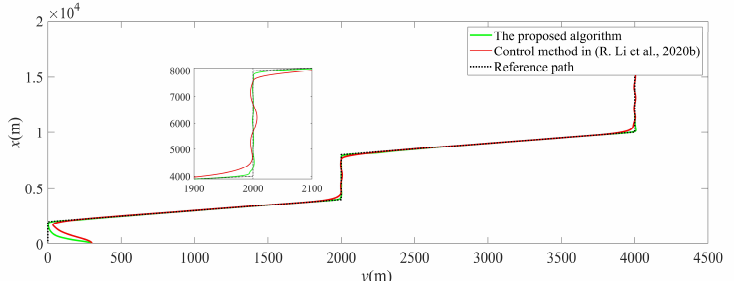
Figure 5. Comparison of path following: proposed algorithm and control method in [32].